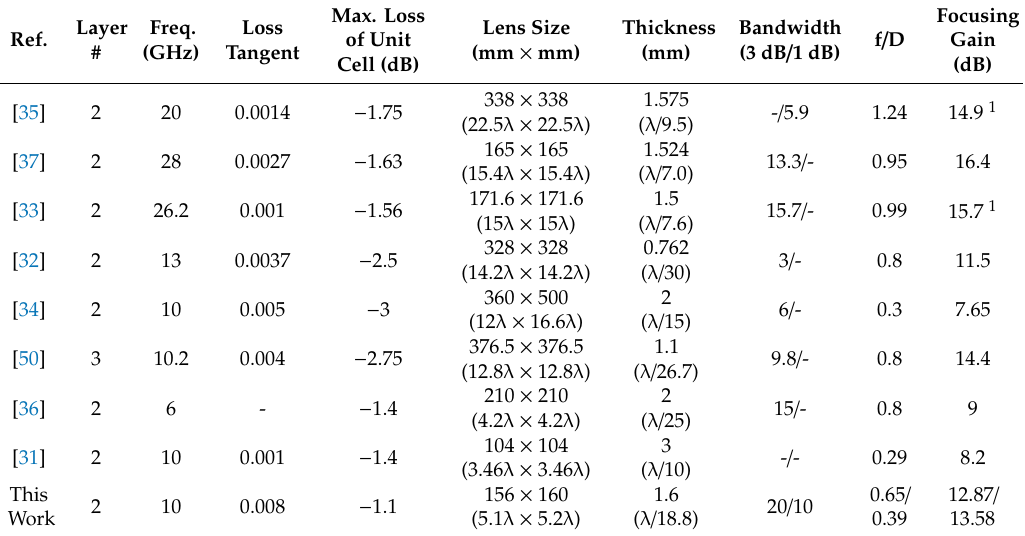
Table 2. Performance comparison of the proposed focusing lenses with the referenced designs.